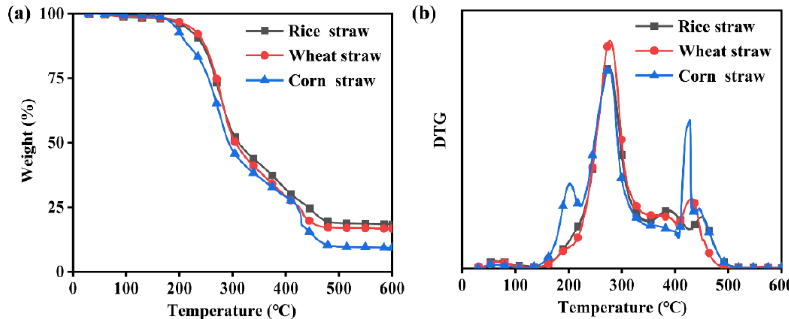
Figure 1. TGA curves ( a ) and DTG curves ( b ) of the crop straws..